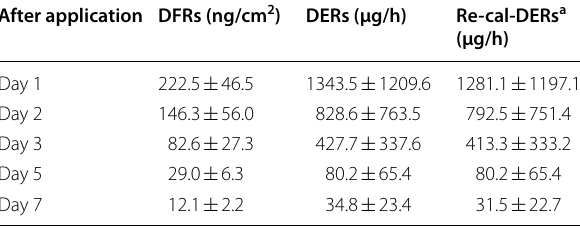
a Dermal exposure rates (DERs) recalculated using the reference body surface area for Korean adult males [19]